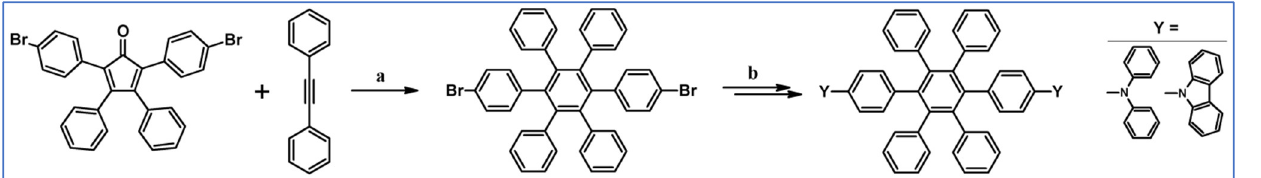
Scheme 59. DA cycloaddition with CO extrusion for the synthesis of hexaphenylbenzene derivatives bearing diphenylamine or N -carbazole moieties [113]. Reagents and conditions: a = PhCOPh, 300 °C, 0.33 h, Y = 77%; b = next steps.